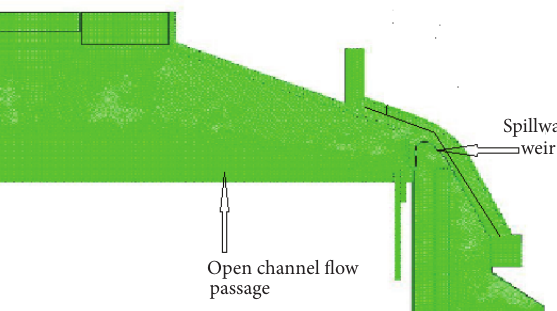
Figure 10: Mesh generation in the fluid domain.